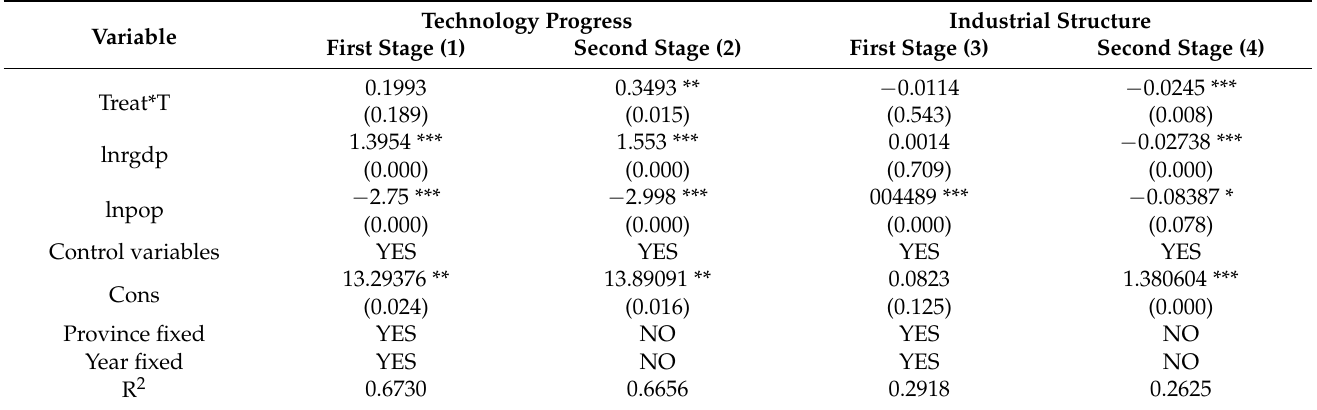
Table 9. Regression results of policy action